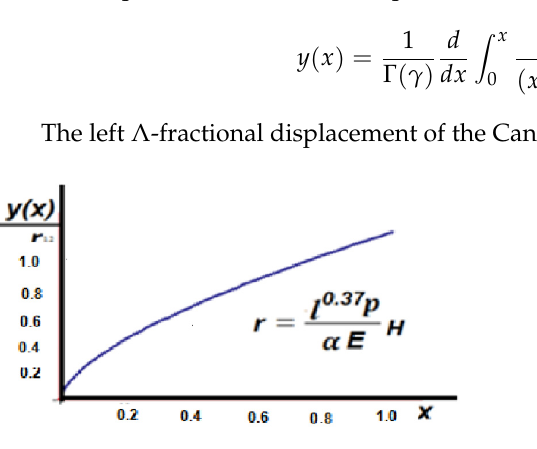
Figure 26. The left Λ -fractional displacement of the Cantor rod in the initial space. Further, the average left and right displacement of the extended Cantor rod is shown in Figure 27.